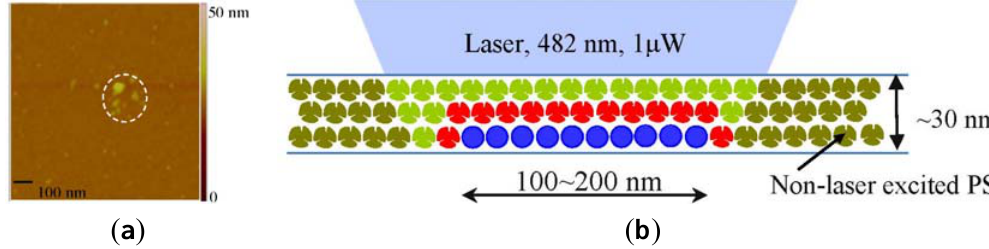
Figure 6. AFM image of large, aggregated Ag nanoparticles ( a ) and conceptual drawing of laser illumination of Ag nanoparticles coated by a PSI thin film (~30 nm thickness) ( b ). Reprinted with permission from [21]. Copyright 2015 American Chemical